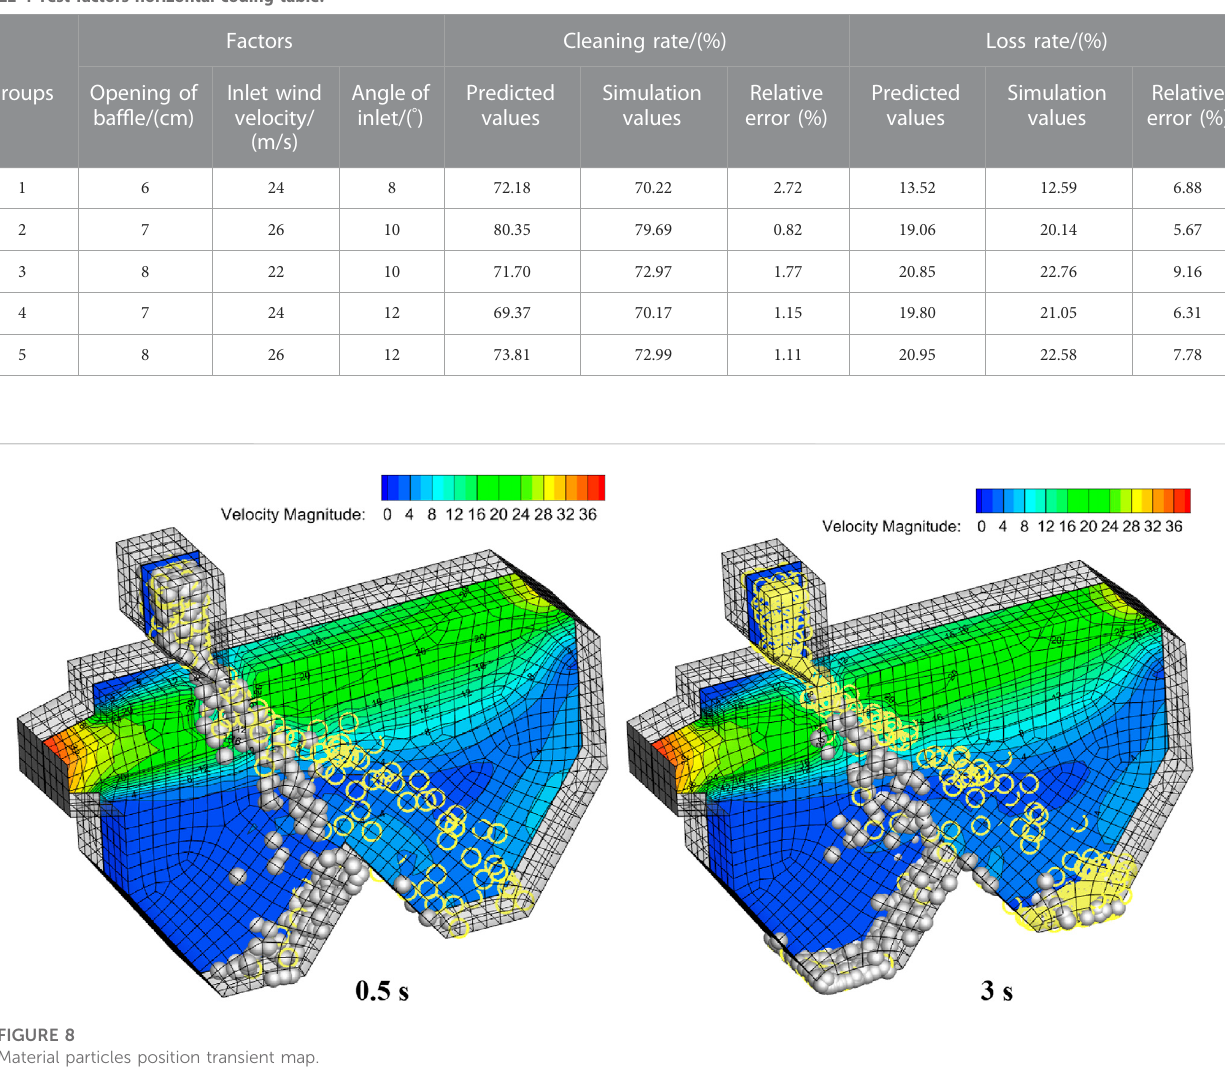
TABLE 4 Test factors horizontal coding table.